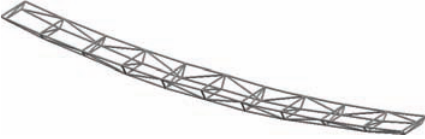
Figure 11: Designed keel structure.